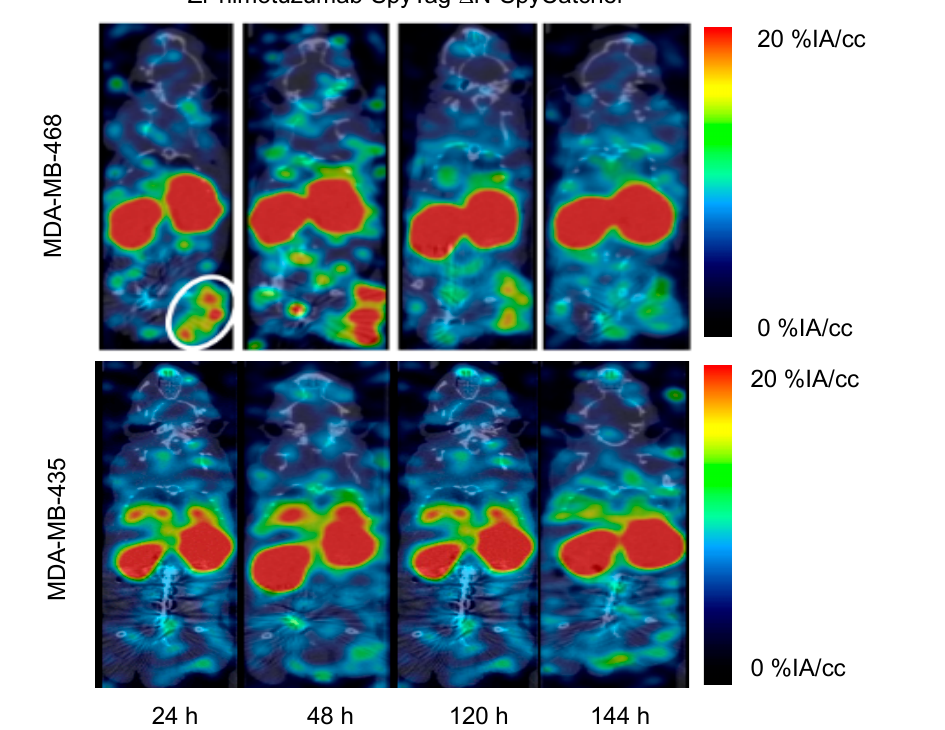
Figure 4. Representative microPET/CT fused images of 89 Zr-nimotuzumab-SpyTag- Δ N-SpyCatcher tracer injected via tail vein in CD-1 athymic nude mice bearing EGFR-positive (MDA-MB-468) or EGFR-negative (MDA-MB-435) xenografts. Location of xenograft is depicted with a white cycle.